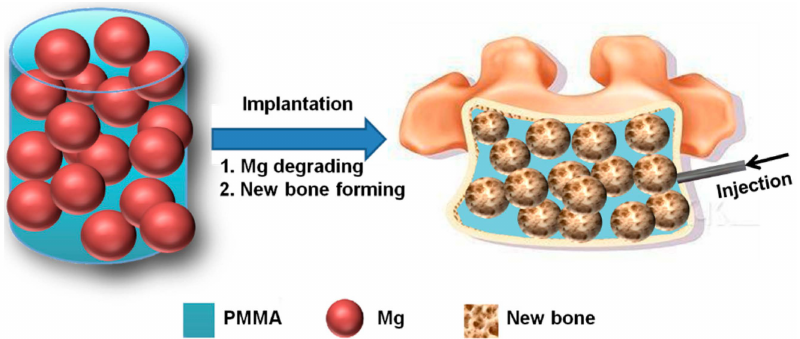
Figure 1. Schematic illustration of a partially degradable PMMA bone cement based on the “magnesium sacrifice” strategy.